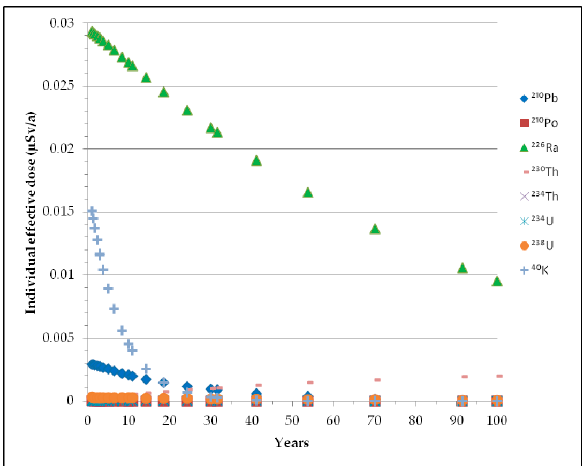
Figure 2. The trend of annual individual effective dose (µSv/a ) for single radionuclides in the years following the occasional spreading of fertilizers.